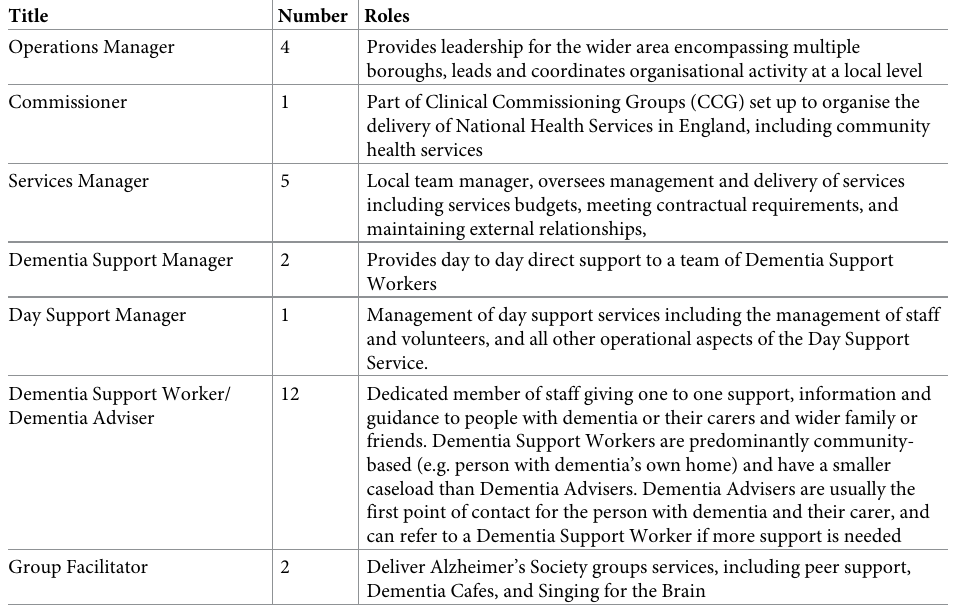
Table 1. Pre-intervention interviews–stakeholder titles and